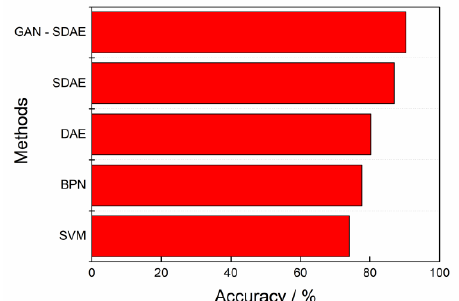
Figure 21. The results of the gear fault diagnosis.